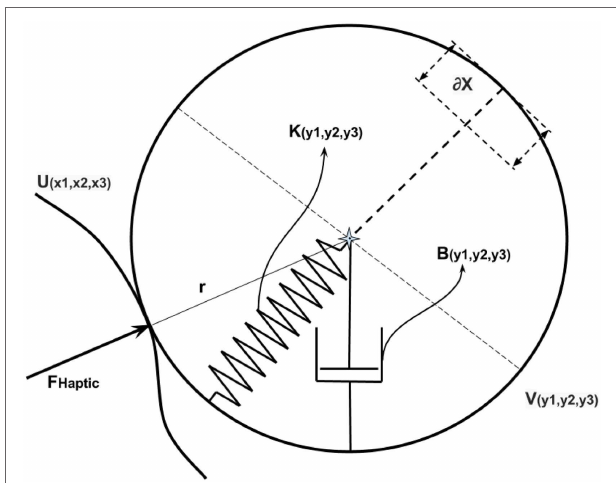
FIGURE 7 | Spherical proxy region modeled as a 3-dimensional spring and damper .